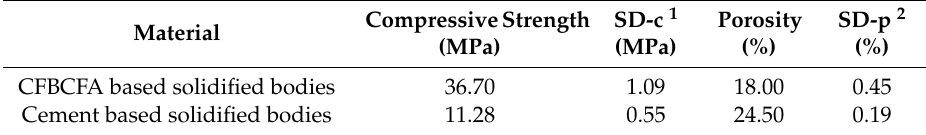
Table 3. The porosity and compressive strength of solidified bodies.